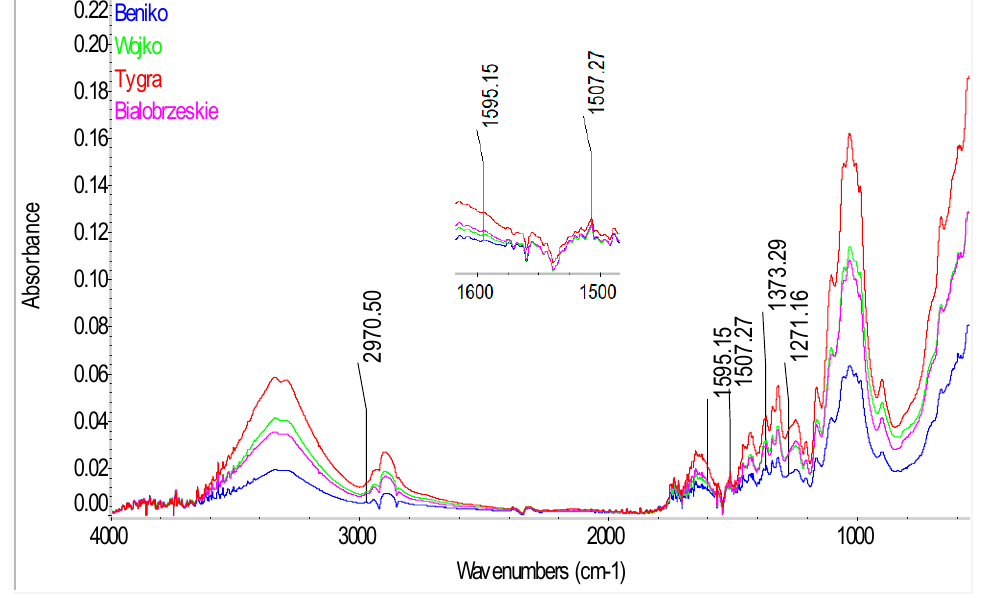
Figure 8. The Fourier transform infrared Attenuated Total Reflection spectra of the hemp fibers of Beniko, Wojko, Tygra and Bia ł obrzeskie variety after warm water retting.